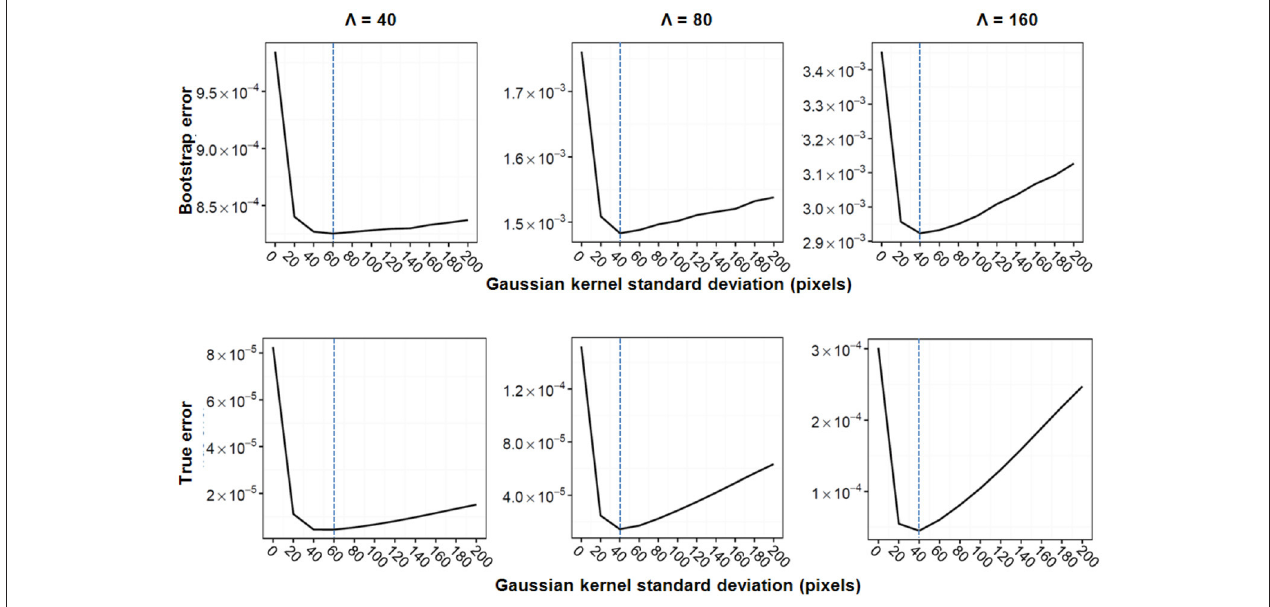
FIGURE 3 | Gaussian kernel standard deviation selection for the three simulation experiments. Bootstrap error (Top) and true error (Bottom) are shown for the exacerbated group. From left to right: 3 = 40, 3 = 80, 3 = 160. The bootstrap error was calculated using 1000 bootstrap samples. Ten Gaussian kernel sizes were tested, minima are indicated with a dashed blue